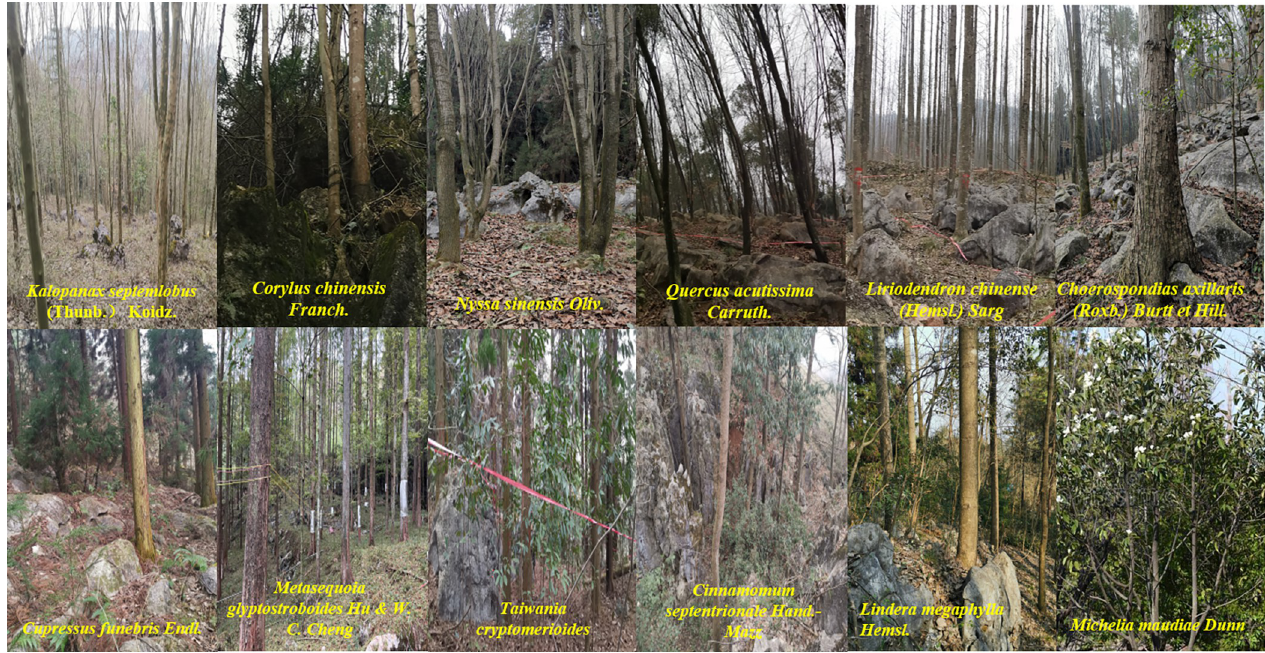
Fig 2. The photos of the 12 representative native precious tree